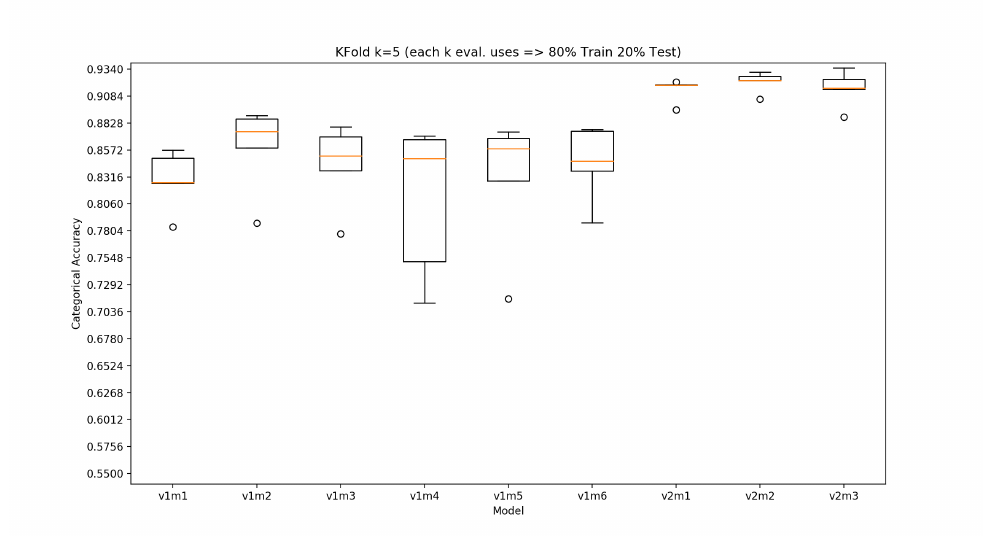
Figure 5. K-fold (k = 5) test accuracy for selected models on the IGN-PNOA dataset.